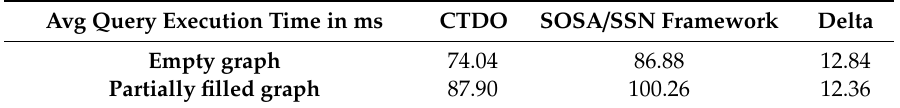
Table 2. Comparison of the result of query execution times on the completely empty and partially filled